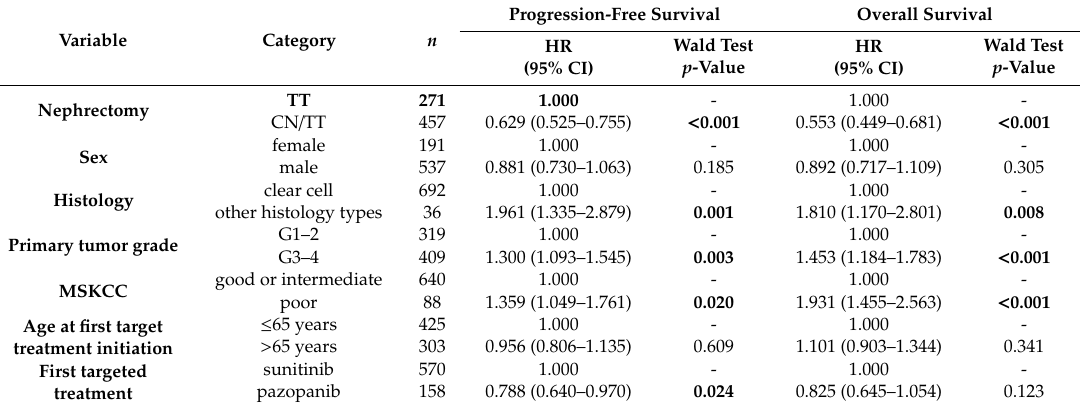
Table 2. Progression-free and overall survival results: multivariable Cox-proportional hazards